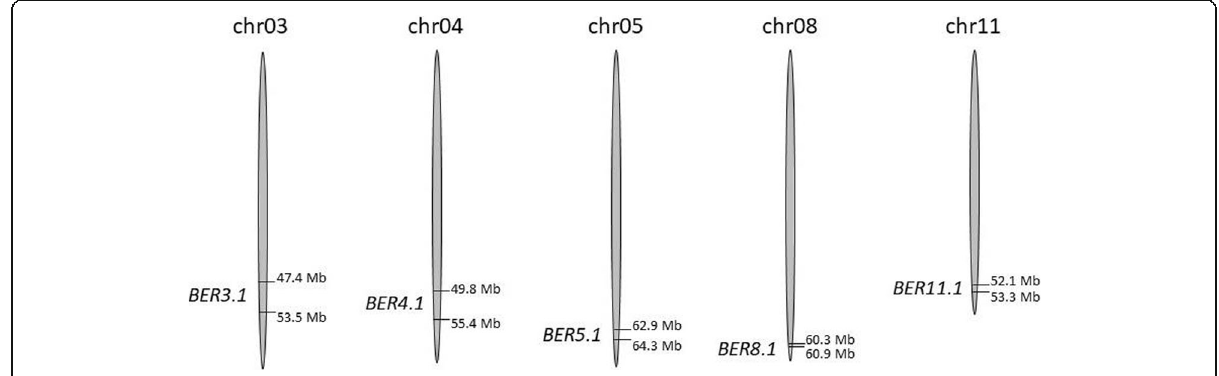
Fig. 3 Location of the five BER loci in the tomato